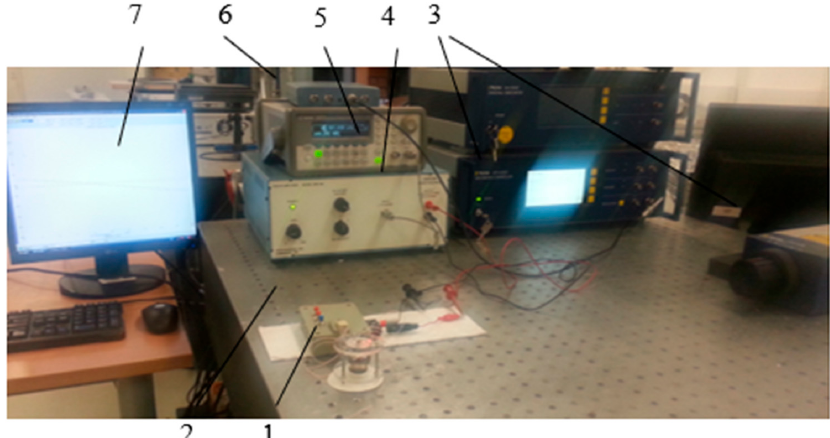
Figure 14. Experimental setup for measurement of resolution of the angular rotation: 1—USM with spherical rotor; 2—controller; 3—Polytec Laser Doppler Vibrometer system OFV512/5000; 4—linear amplifier EPA-104; 5—signal generator Agilent 33220A; 6—oscilloscope PicoScope 3424; 7—PC with a PicoScope and Polytec software.